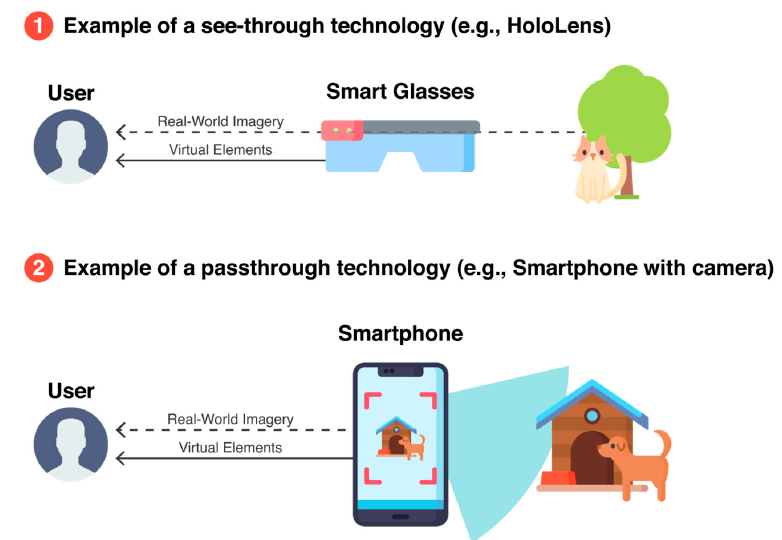
Figure 4. Representation of see-through and pass-through AR technologies.